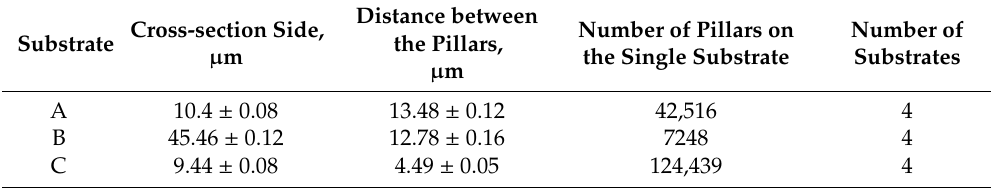
Table 1. Dimensions of the pillars (measured with the above SEM).